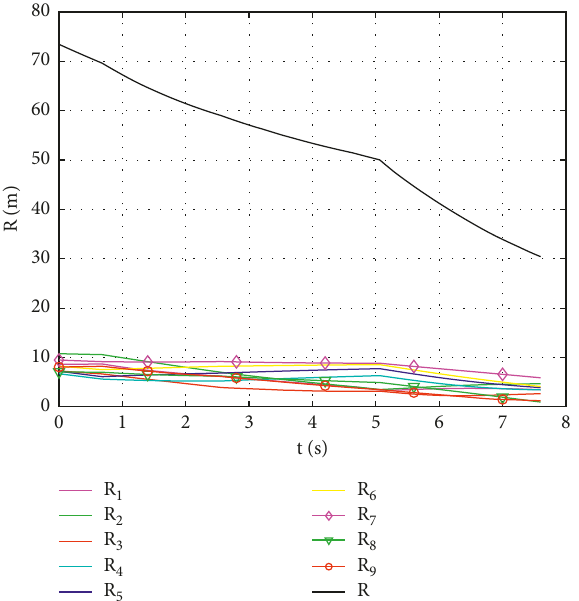
Figure 9: The changes in the distance between pursuers and evader ( N � 9, λ � 0 .